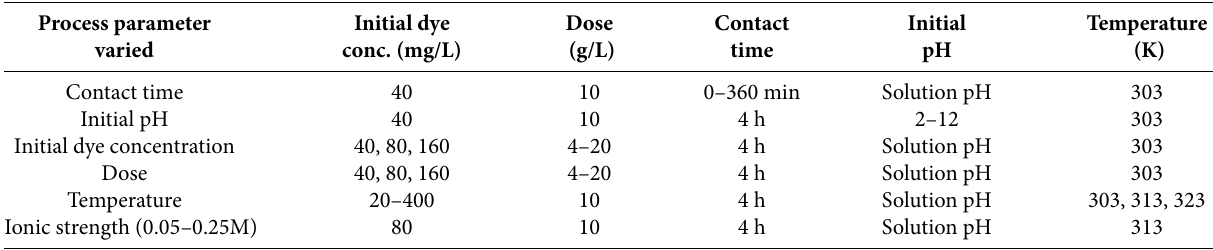
Table 1. Experimental conditions of the adsorption study. Process parameter Initial dye Dose